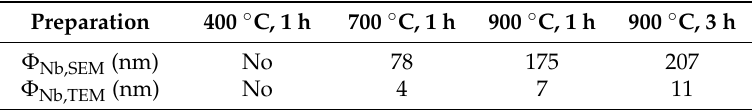
Figure 7. Histograms of Nb particle sizes detected from TEM images showing the Nb particles with sizes less than 50 nm. ( a ) annealed at 700 °C for 1 h; ( b ) annealed at 900 °C for 1 h. Table 1. Summary of Nb particle sizes after annealing under different conditions. (Note: Φ Nb,SEM is the average Nb particle size observed by SEM, and Φ Nb,TEM is the average Nb particle size measured by